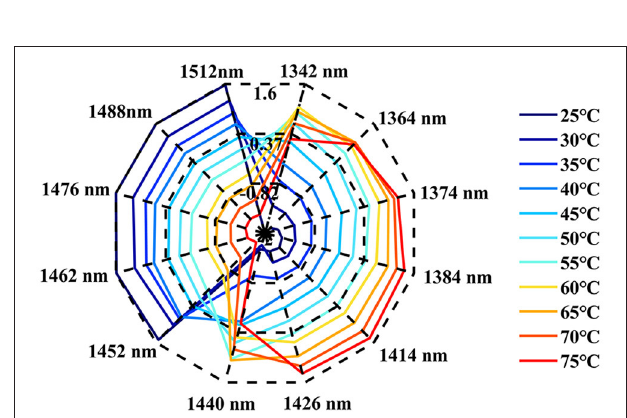
FIGURE 8 | The aquagram of Ara